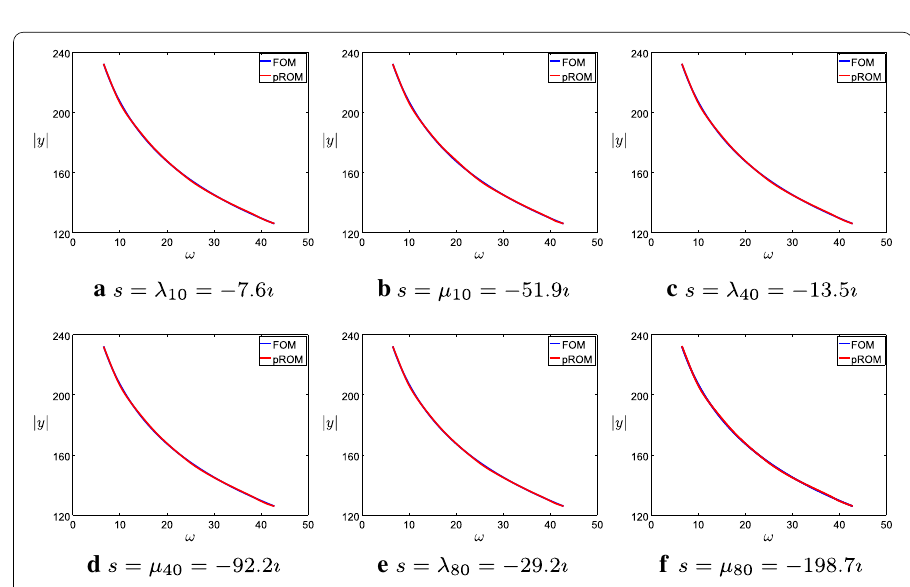
Fig. 5 Interpolation of Loewner ROMs built with global basis using Algorithm 1. The nonparametric Loewner ROMs are built in the compressed form with different frequency shift s . The FRFs at p ∗ = 65 . 51 are shown in the